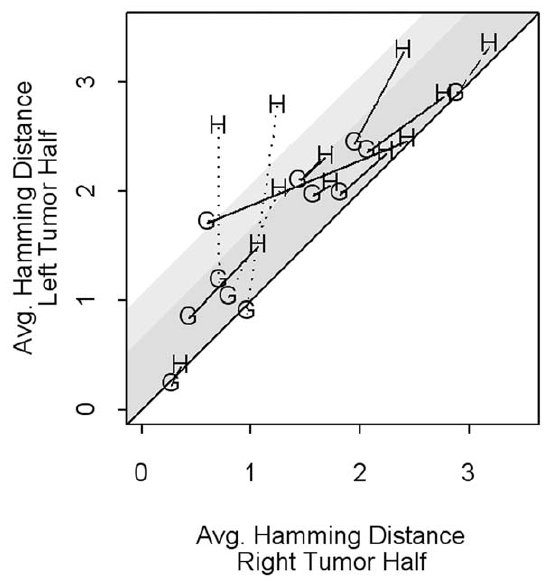
Figure 4. Average Hamming distance by tumor half for the 12 tumors published by Siegmund et al. [3] The x-axis represents the distance in the right tumor half and the y-axis the distance in the left tumor half. Within-gland distances are denoted by G and within-half by H. Lines connect the pairs (G,H) from the same tumor. The line type indicates differences in distance between-half and within-half (BH-WH). Solid lines denote small BH-WH differences (difference , 0.1, 8 ‘‘flat’’ tumors) and broken lines denote larger differences (BH-WH difference . 0.4, 4 tumors). The type of broken line indicates WH differences between left and right tumor half; dotted lines indicate tumors with large WH differences ( . 0.6, 3 tumors); the dashed line indicates one tumor with small WH difference (0.14).